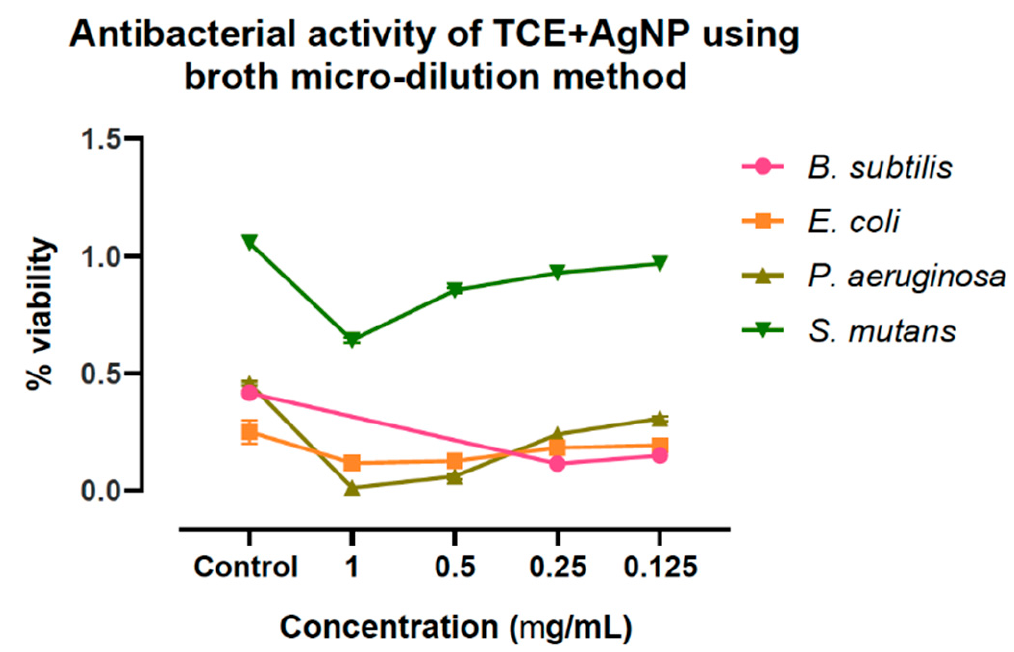
Figure 3. Antibacterial activity of AgNPs prepared using T. chebula fruit extract showing MIC.